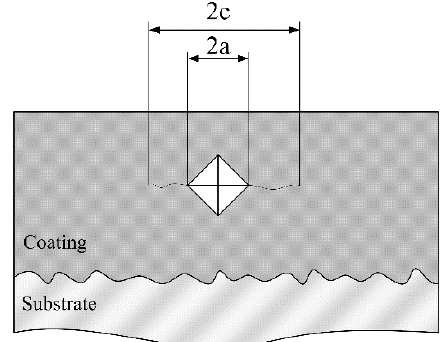
Figure 1. Schematic of fracture toughness measurement with Vickers indentation.